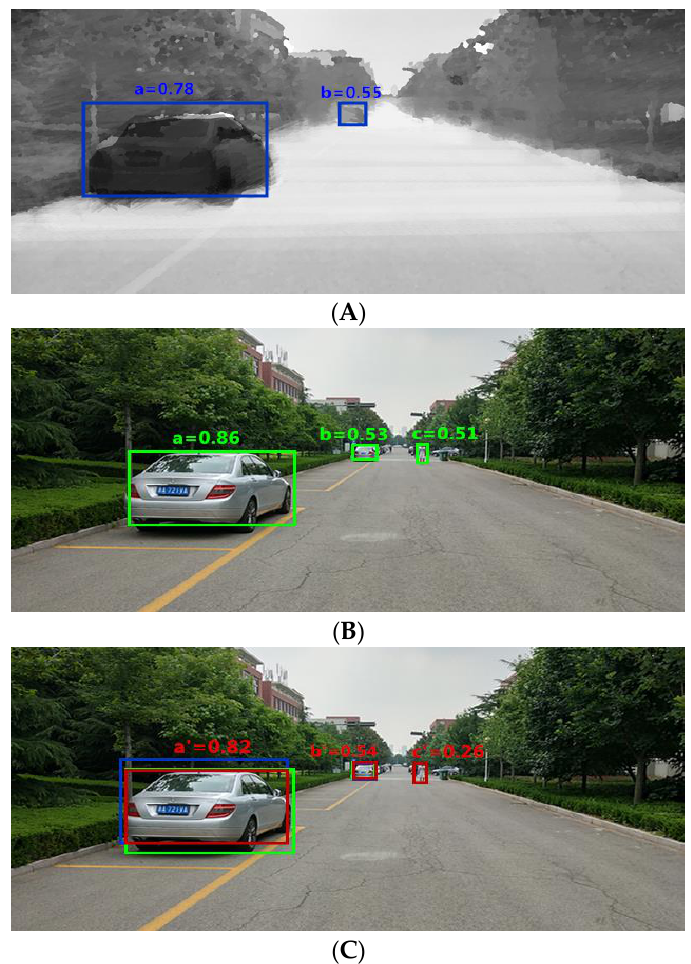
Figure 6. An example of target detection fusion process. ( A ) is a processed depth image. The models